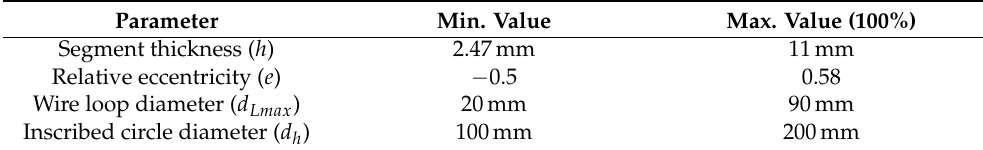
Table 1. Maximum values for the relative magnitudes on the